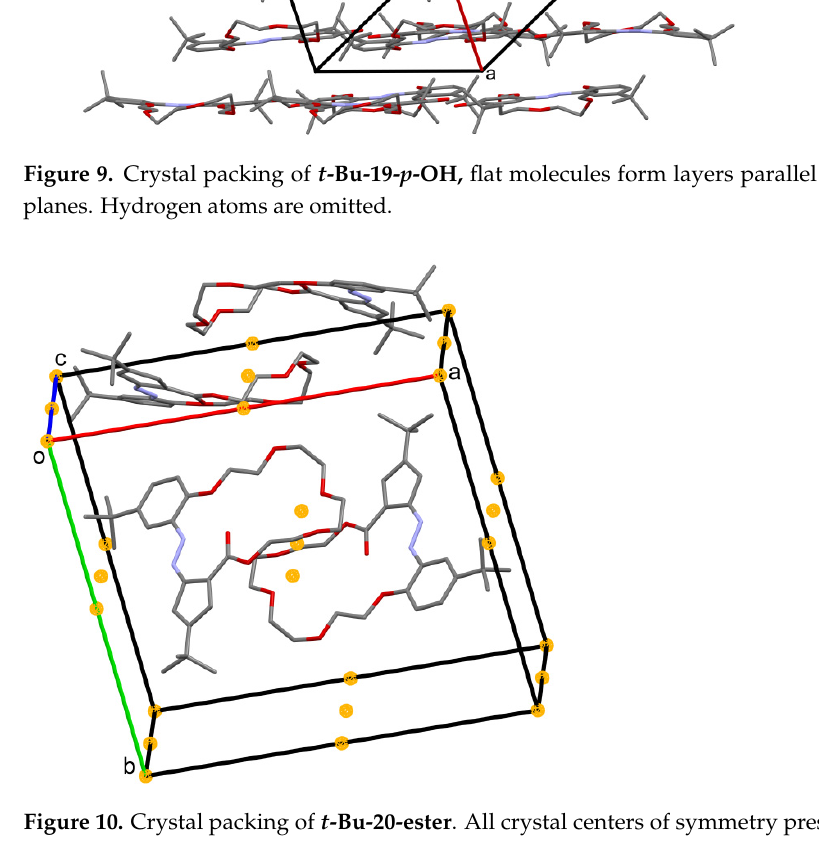
Figure 10. Crystal packing of t -Bu-20-ester . All crystal centers of symmetry present in unit cell are drawn as orange balls, and the glide planes and screw axes are omitted.